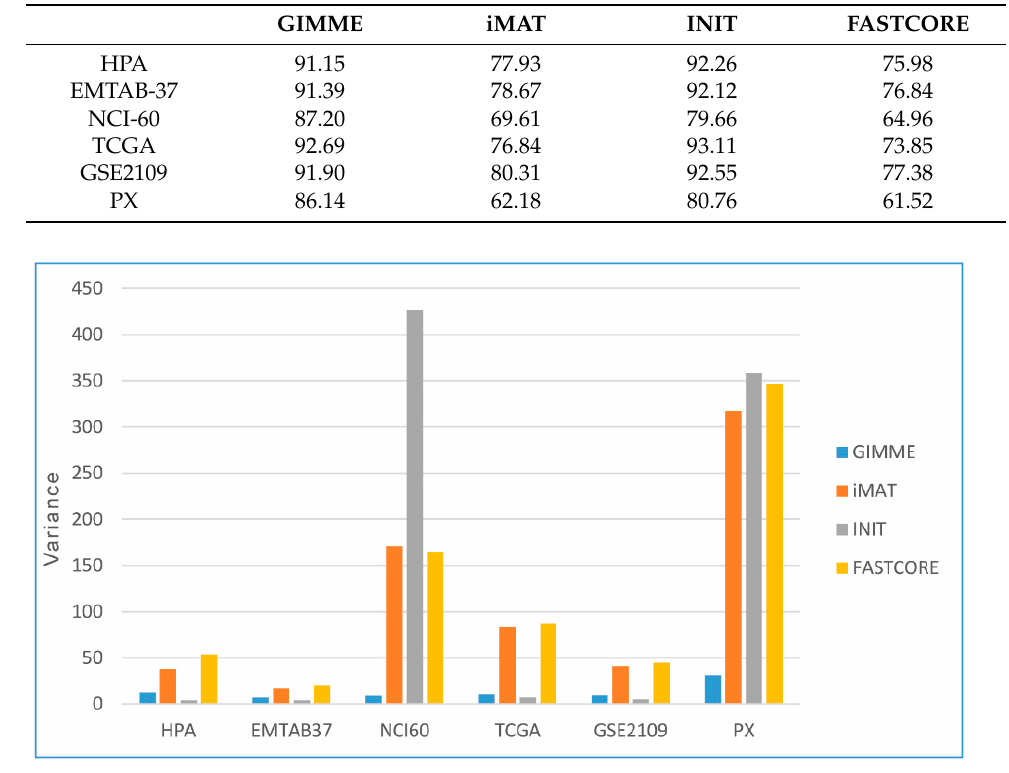
Figure 3. The variance distribution of activated cancer genes among CGEMs. Proteome-based CGEMs show the highest variance distribution of activated genes.